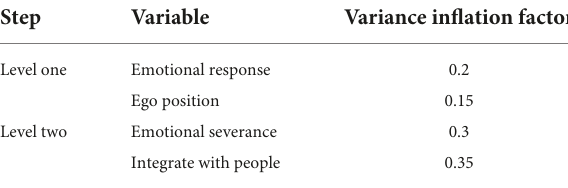
TABLE 2 Multiple regression results of self-differentiation, anxiety and